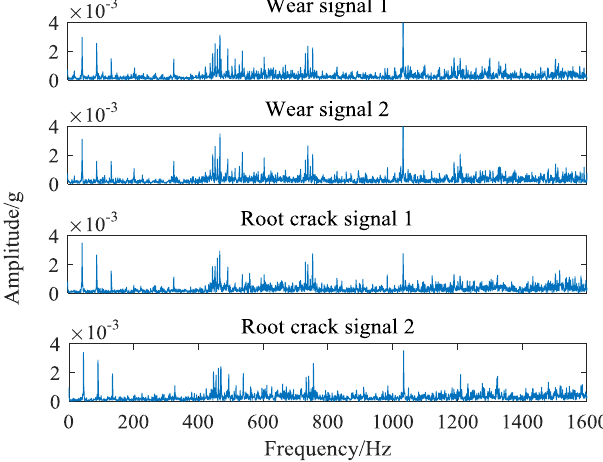
Figure 6. Highly similar vibration signals: wear and root crack.